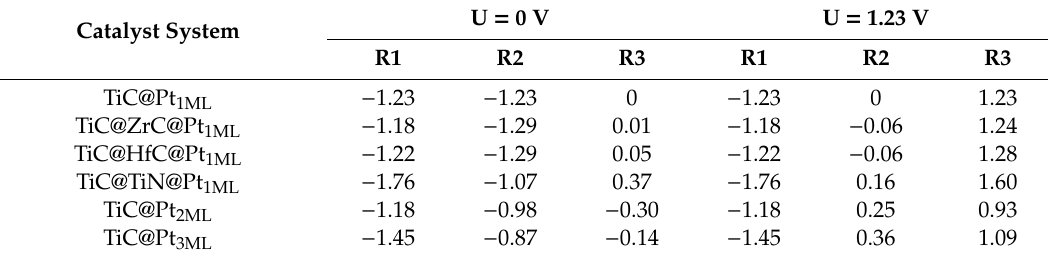
Table 3. The free energy change ∆ G at the potential of 0 V and 1.23 V.